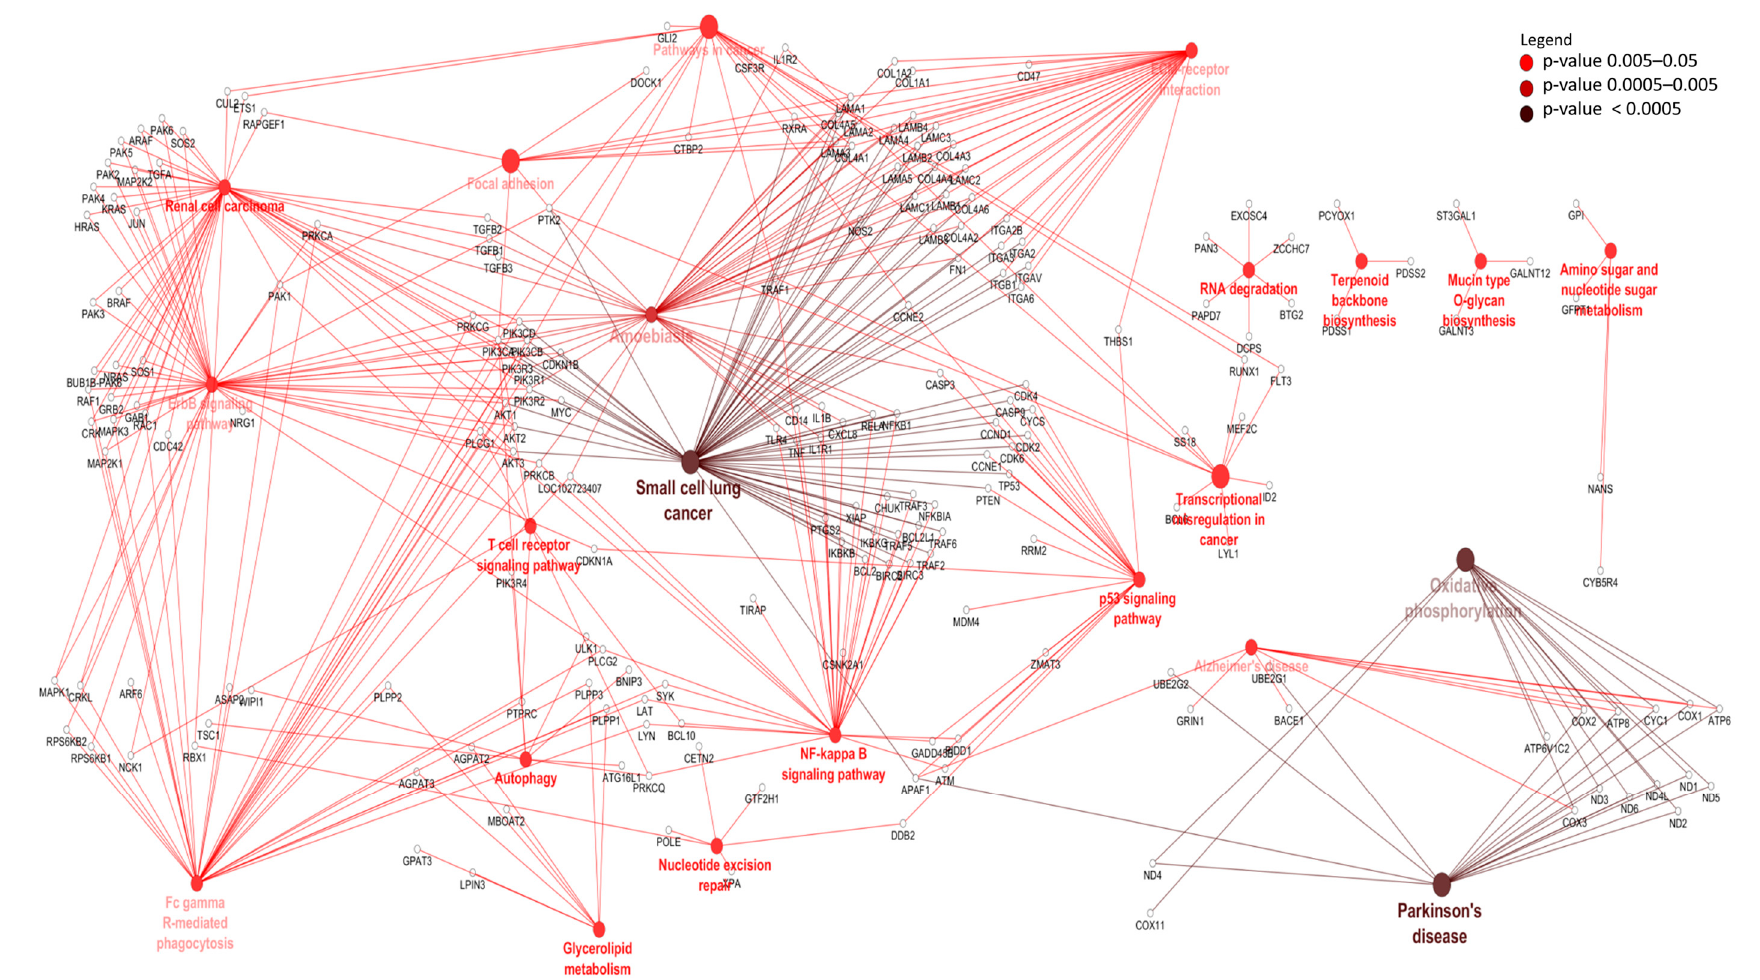
Figure 4. Kyoto Enciclopedia of Genes and Genomes pathways enriched for rumen lncRNA potential cis target genes. ErbB: Epidermal growth factor receptor; Fc: Fragment crystallisable region; NF- κ B: Nuclear factor- κ B.